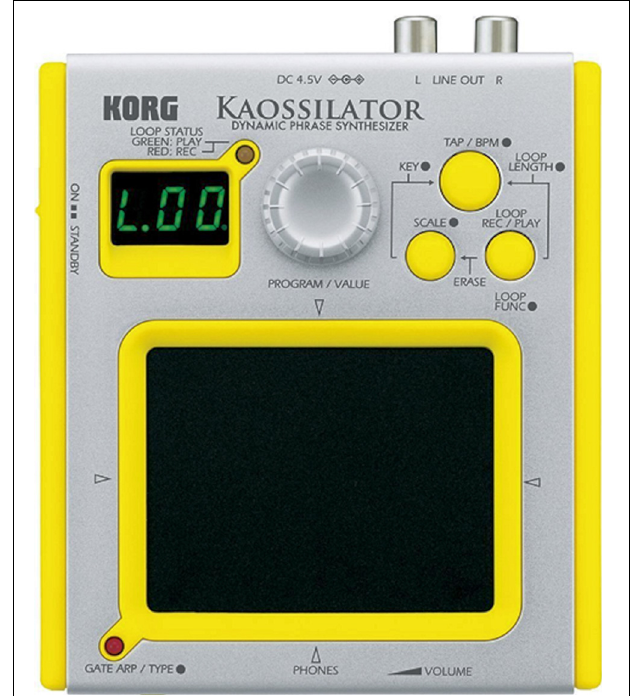
FIGURE 7 | The synthesizer used. Participants were asked to create complex sounds by layering sounds into a two bar (8 beats) phrase using a Korg Kaossilator. Sounds are selected via the wheel at the top of the device and synthesized when users touch the black pad in the lower portion of the device. The position of the finger determines the characteristics of the synthetic